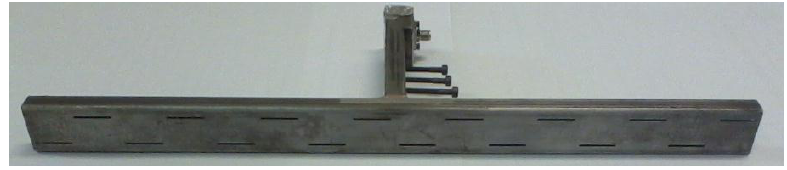
Figure 6. Picture of one of the transmitting slot antenna